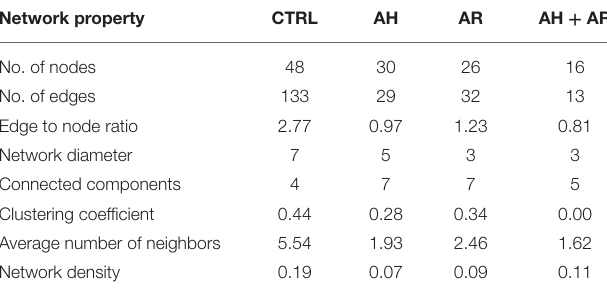
TABLE 2 | Topological properties of computed correlation